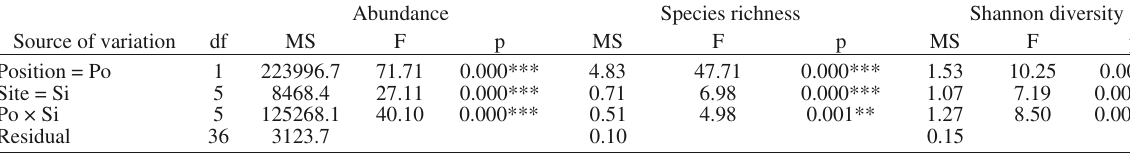
Table 1. – Results of the two-factor ANOVA for abundance of individuals, species richness and Shannon-Wiener diversity. No transforma- tions were necessary for diversity and abundance values. Species richness data were Ln(x) transformed; df, degrees of freedom; MS, mean